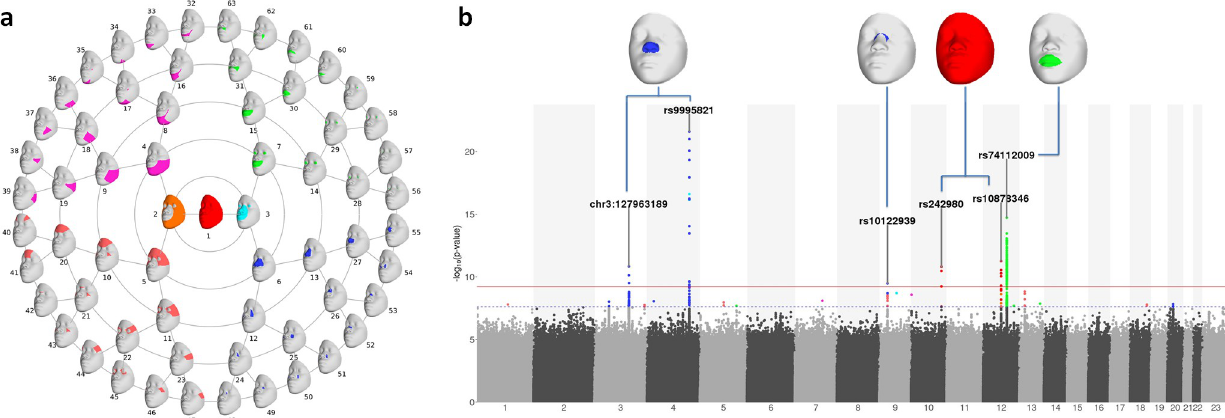
Fig 1. Facial segmentation and GWAS results. (a) Rosette showing the global-to-local partitioning of the full face into segments. The full face (segment 1, red) is first partitioned into segments representing the outer (2, orange) and inner (3, cyan) regions of the face. These are in turn partitioned into more localized regions representing the lower face (magenta), upper face (salmon), nose (blue), and mouth and eyes (green). (b) Combined Manhattan plot highlighting the genome-wide significant genetic variants across 63 facial segments. Significantly associated variants are colored to correspond to the facial segments as shown in (a). The blue dotted line and red solid line indicate the genome-wide (P < 2.5 × 10 − 8 ) and study-side (P < 6.25 × 10 − 10 ) significance thresholds, respectively.